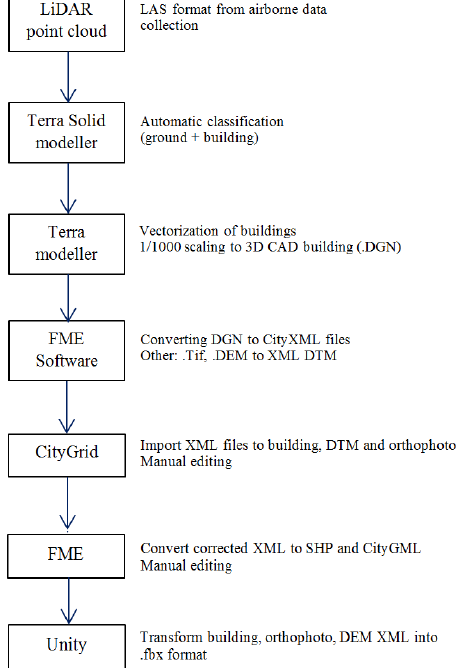
Figure 6. Pre-processing phase for unity input